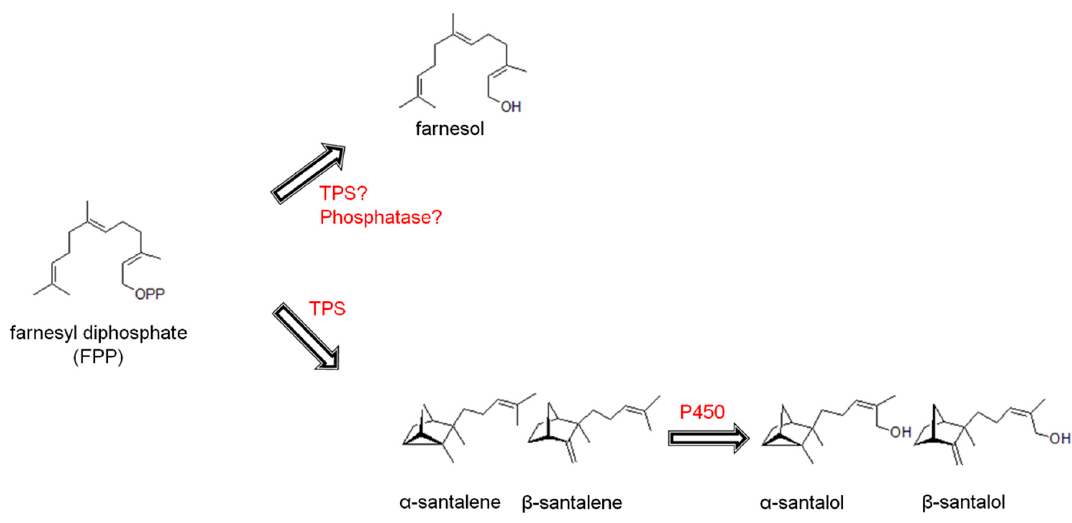
Figure 1. Biosynthesis of major sesquiterpene alcohols in S. spicatum. Proposed formation of farnesol from farnesyl-diphosphate (FPP) via a terpene synthase (TPS) or phosphatase activity, and the known